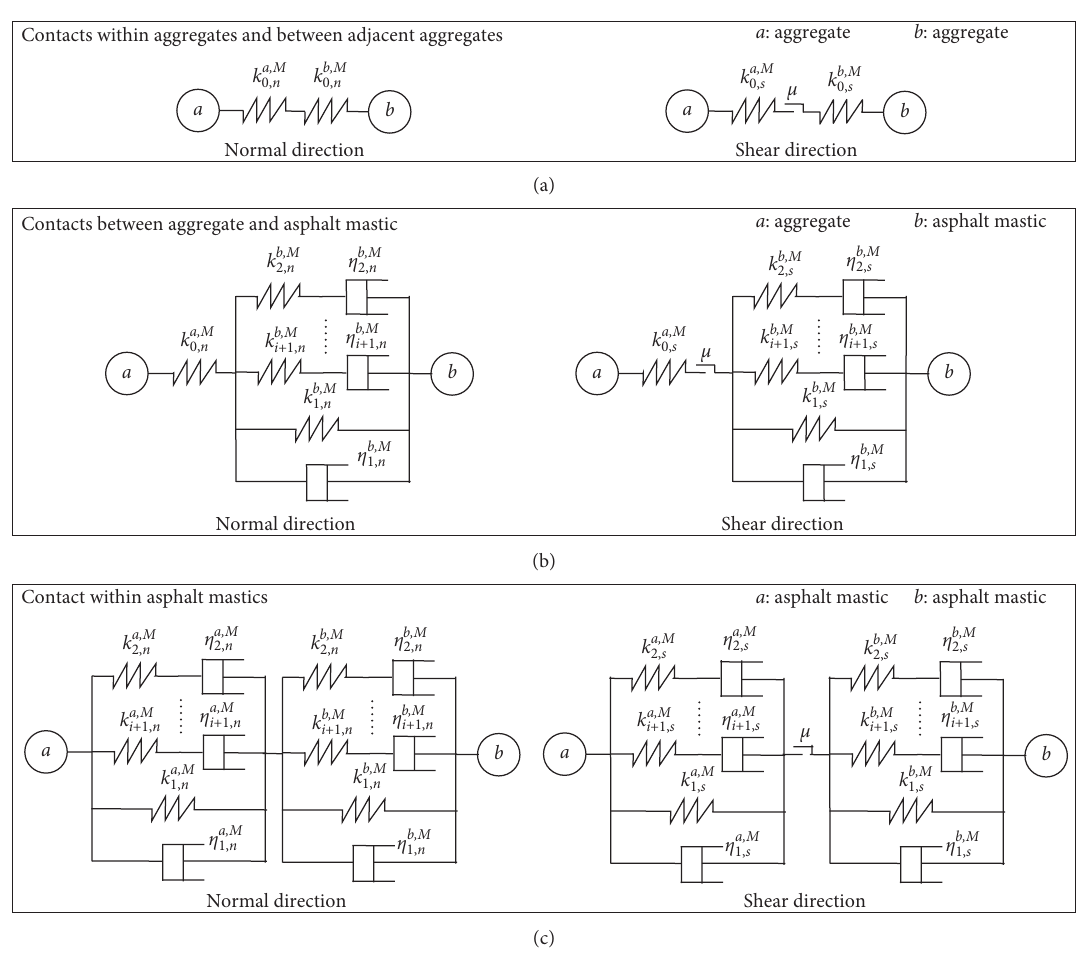
Figure 3: Constitutive relation of contacts in numerical samples using the M-model.